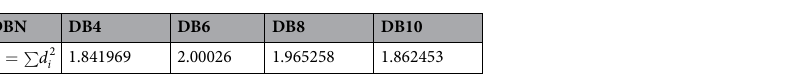
Table 2. Total energy of the high frequency coefficients after wavelet DBN